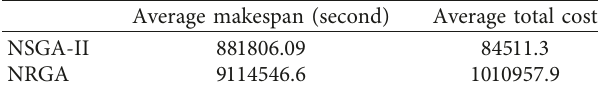
Table 12: Comparison of results for all